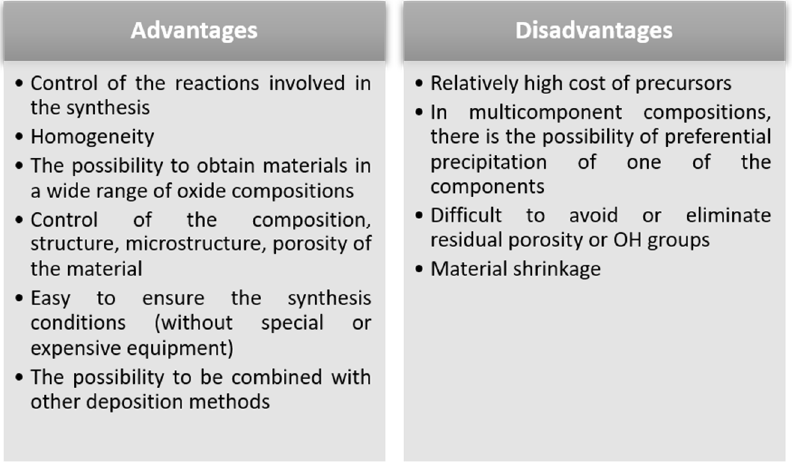
Figure 2. Synthesis scheme for sol-gel method.